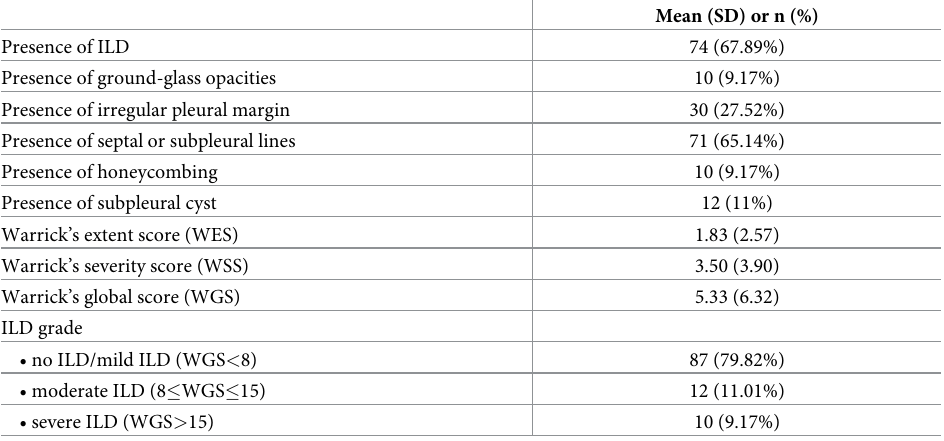
Table 2. HRCT of the chest